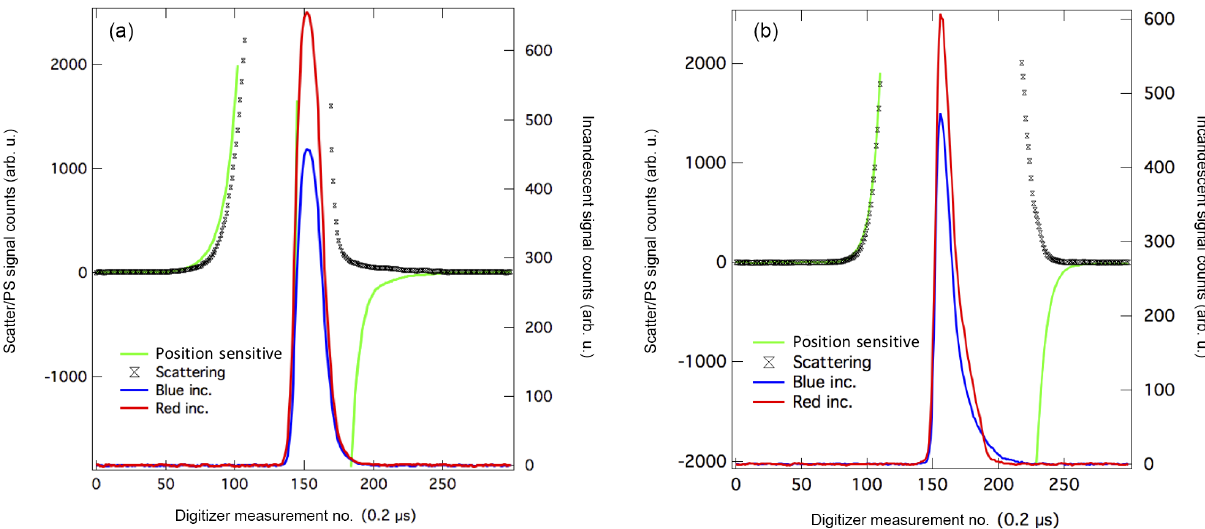
Figure 3. Comparison of SP2 signals. SP2 traces for two different aerosols with metallic components with similar incandescent peak heights and color ratios. (a) is from laboratory samples of Fe 3 O 4 and (b) is from a mineral dust particle. Black indicates the scattering signal, green is the position-sensitive detector, red is the red PMT signal, and blue is the blue PMT signal. For the particle signal shown in (a) , the scattering signal disappears as the particle incandesces (around the 200th digitizer measurement point), indicating complete evaporation of the particle. For the particle signal shown in (b) , scattering is still present after the incandescent signal has returned to the baseline, indicating that nonevaporative portions of the particle still remain after passing through the SP2